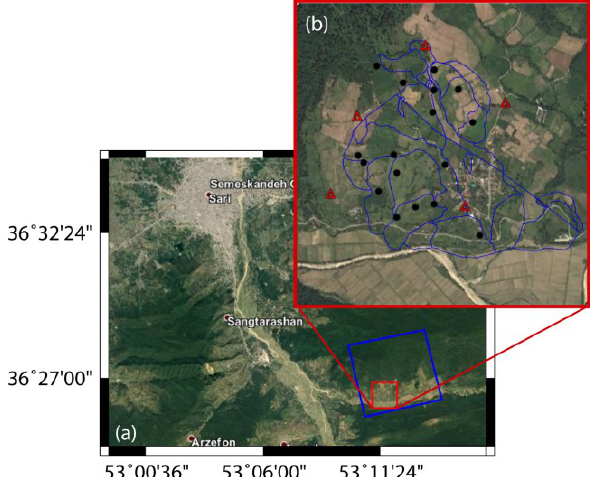
Figure 1: Google Earth image of the study area. Shabkola village is highlighted with a red rectangle in the south east of Sari city. Blue rectangle in figure (a) shows the footprint of the cropped radar images used in this study. Blue polygons in figure (b) show the active region of Shabkola landslide while red triangles and black circles are the reference and measuring GPS stations, respectively.